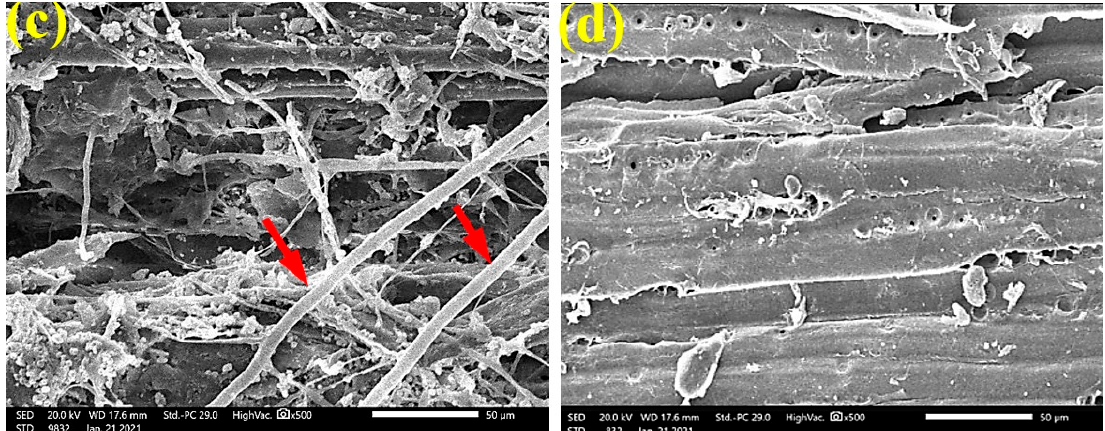
Figure 6. SEM images of P. roxburghii wood samples inoculated with A. niger : ( a , b ) without treatment; ( c ) with 65 µL/mL M. longifolia EO; ( d ) with 125 µL/mL M. longifolia EO. Arrows refer to the dense growth of fungal mycelia in wood samples, according to treatment.